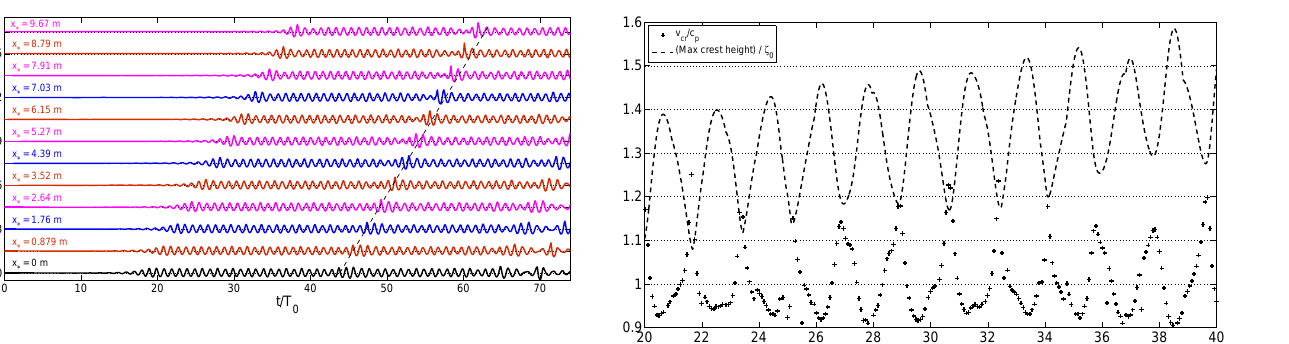
Figure 4. Surface elevation variation at fixed values of x ∗ vs. time t . The group velocity is c g = 0 . 63ms − 1 ; x ∗ refers to the wave gauge distance from the wavemaker at x ∗ = 0.